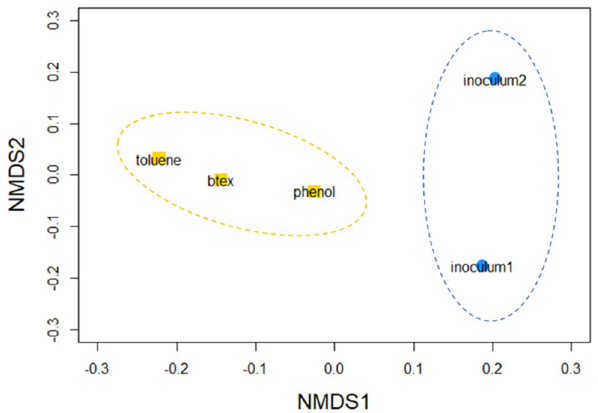
Figure 2. Non-metric multidimensional scaling (NMDS) plot of functional distributions, based on normalized abundances of KEGG Orthology (KO) numbers. Yellow squares indicate graphite granule samples from the three treatments. Blue dots indicate the two inocula.